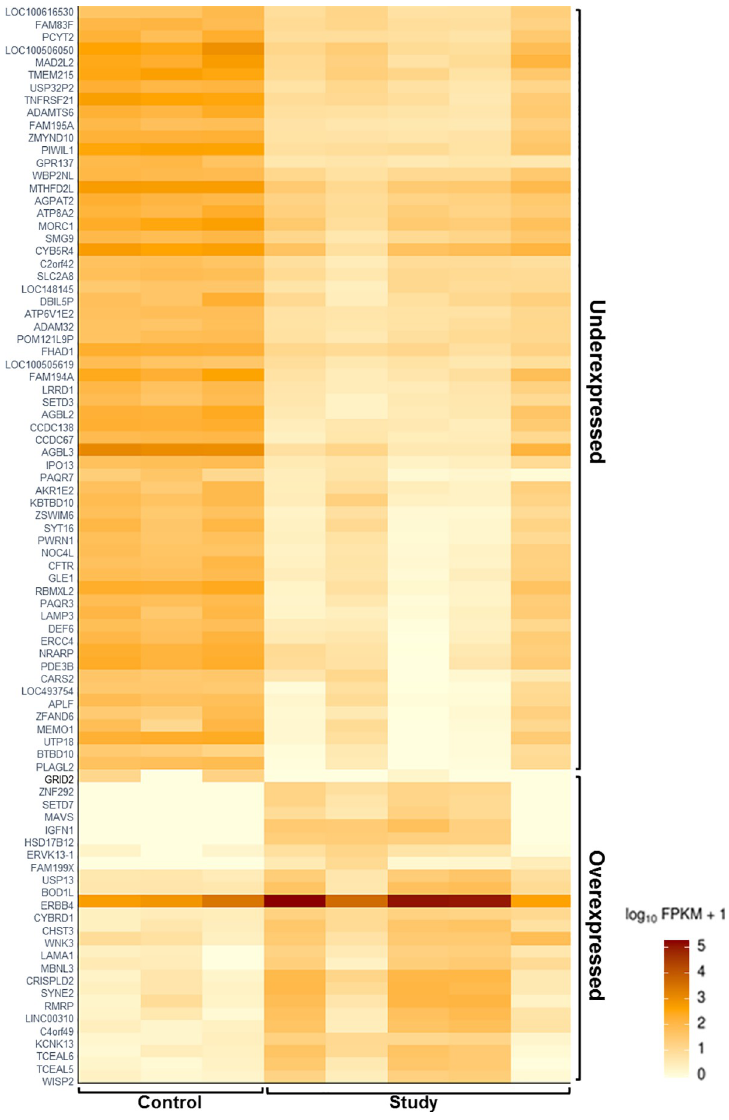
Fig 10. Heat map depicting the differentially expressed genes (by RNA analysis in spermatozoa) in the study group versus the reference control. Within the study group, there were 24 over-expressed (bottom right) and 62 under-expressed genes (top right) identified.